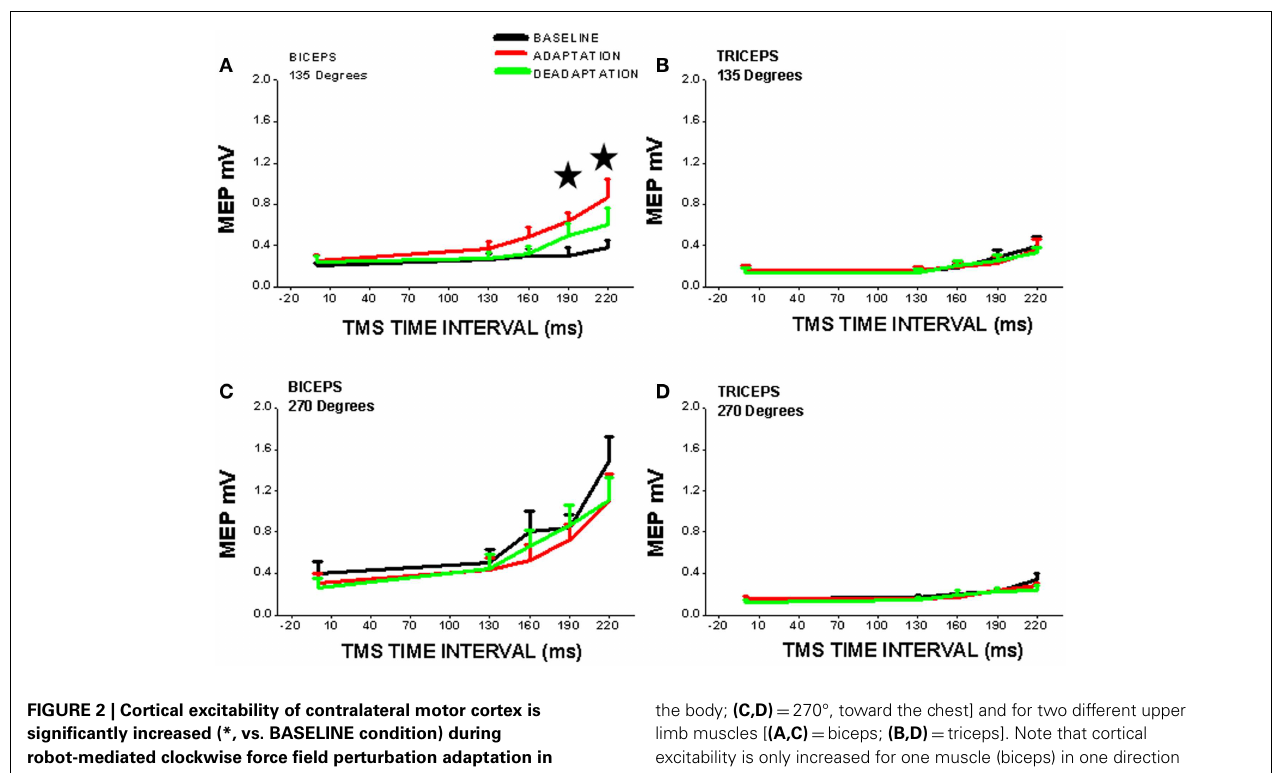
FIGURE 2 | Cortical excitability of contralateral motor cortex is significantly increased (*, vs. BASELINE condition) during robot-mediated clockwise force field perturbation adaptation in healthy subjects (ADAPTATION condition cf. BASELINE and DEADAPTATION conditions) .TMS was used to measure cortical excitability during the movement preparation period before reaching (TMS time interval is time after visual signal to start reach and is set at x = 0 on x -axis) to two different directions [ (A,B) = 135°, away from